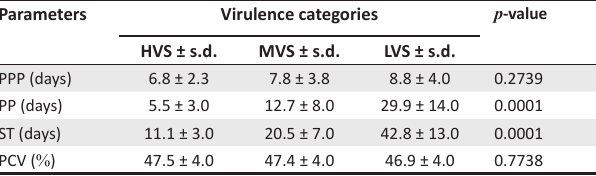
TABLE 2: Mean pre-patent period, patent period, survival time and the packed cell volume progression of South African Trypanosoma congolense strains belonging to high, moderate and low virulence strains.